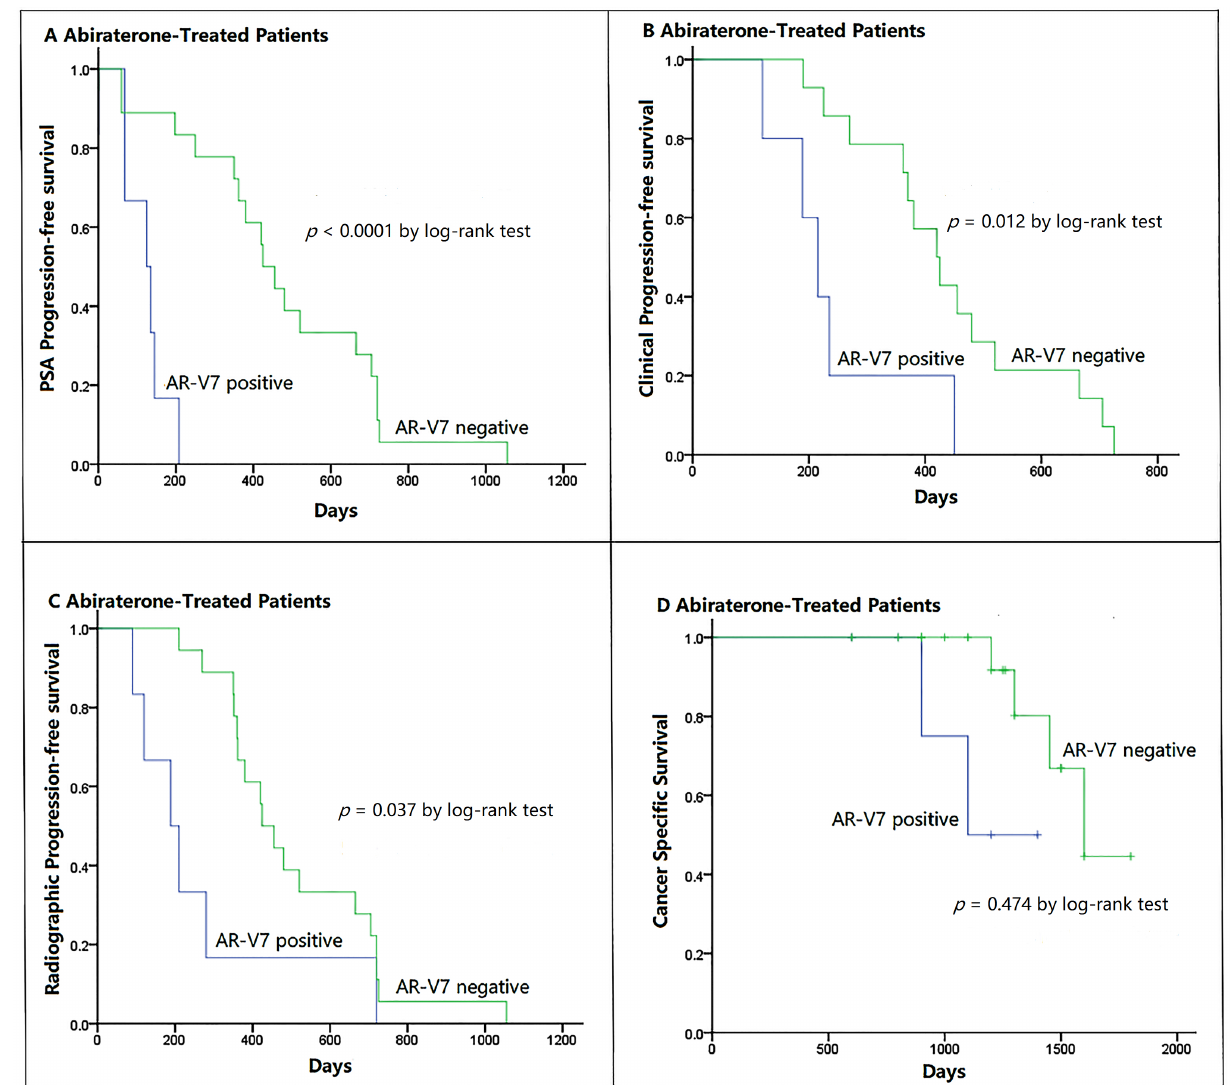
Fig. 1. Kaplan–Meier analysis of prostate specific antigen (PSA) progression free survival (PFS), clinical PFS, radiographic PFS and cancer specific survival (CSS) according to androgen receptor splice variant 7 (AR-V7) status in abiraterone (Abi) treated patients. (A) PSA PFS of AR-V7-negative patients was longer than AR-V7-positive patients by log-rank test, p < 0.0001. (B) Clinical PFS of AR-V7-negative patients was longer than AR-V7-positive patients by log-rank test, p = 0.012. (C) Radiographic PFS of AR- V7-negative patients was longer than AR-V7-positive patients by log-rank test, p = 0.037. (D) No differences in CSS were observed according to AR-V7 status by log-rank test, p =